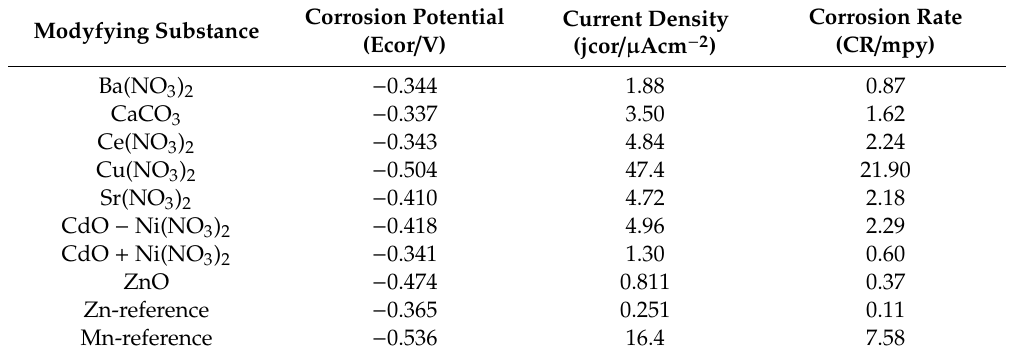
Table 7. Values of the corrosion potential, current density, and corrosion rate for the modified samples. Modyfying